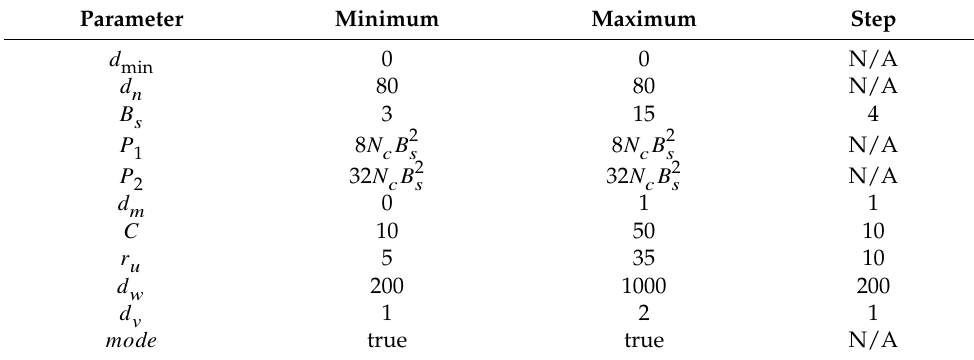
Table 1. Configuration of point cloud parameters.